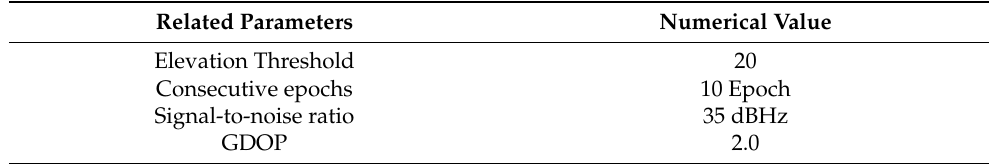
Table 1. Combination optimization algorithm parameter